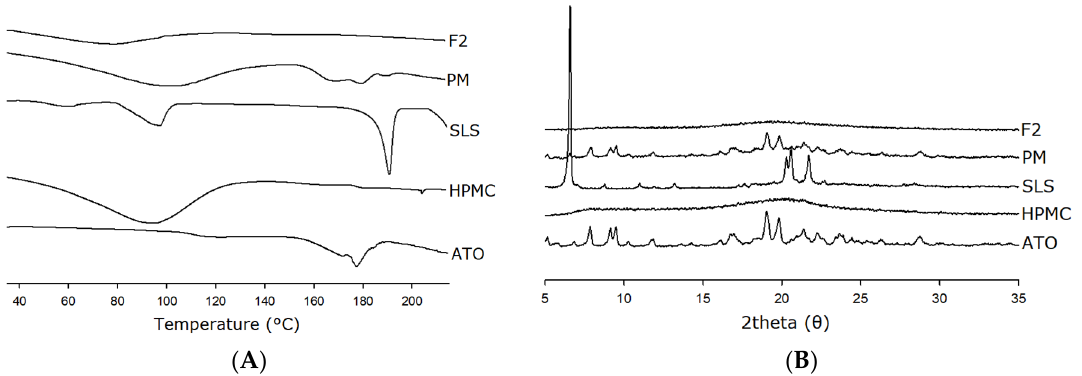
Figure 5. DSC ( A ) and XRD ( B ) curves of samples. PM represents a physical mixture of ATO, HPMC, and SLS at a 1:1:0.1 ( w / w / w ) ratio.